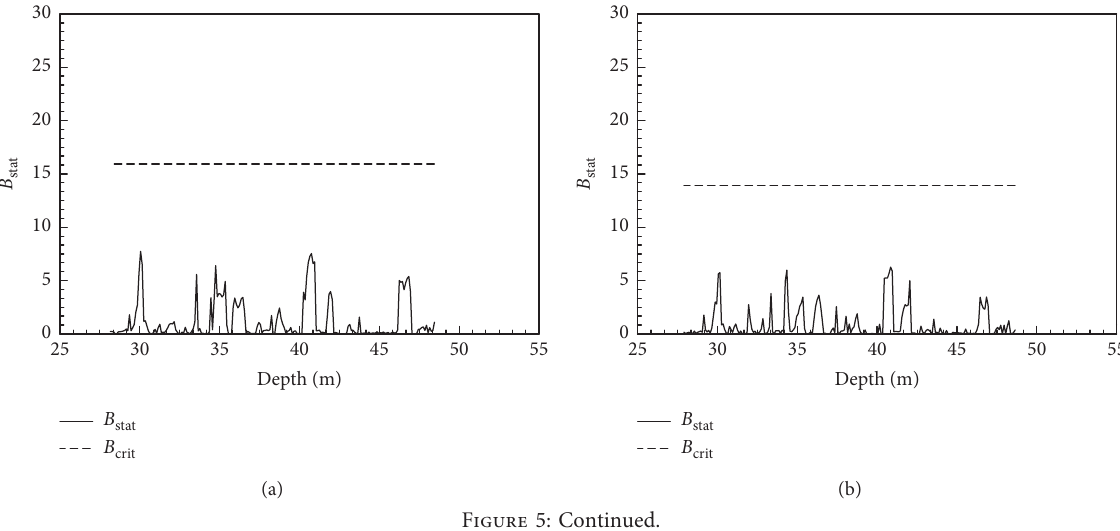
1 . (b) M 2 . (c) M 3 . (d) M 4